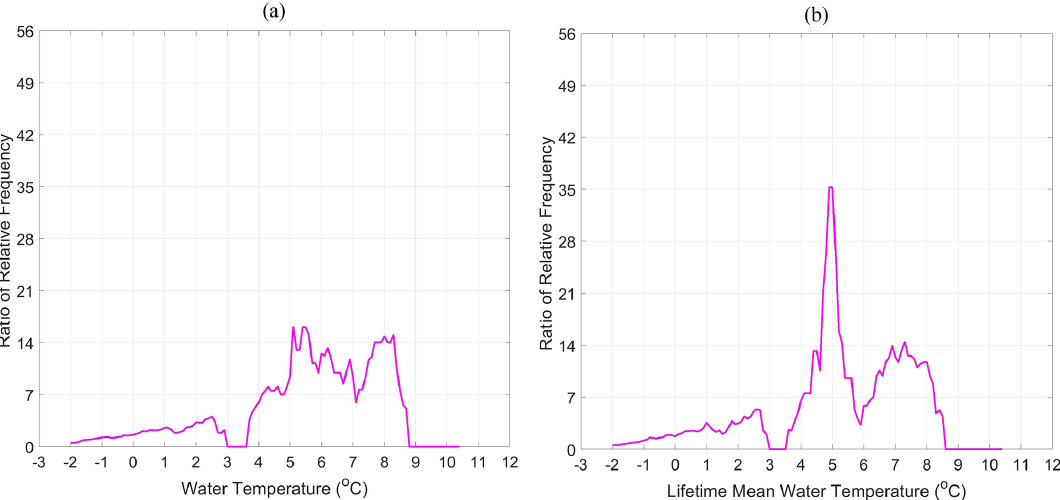
Figure A1. The ratio of the relative frequency for fracture events and all observations over the range of water temperature (a) and lifetime mean water temperature (b) that surrounded the Petermann ice islands. Values close to 1 imply that fracture events are as likely to occur as the frequency of observations. Values larger than 1 indicate that fracture events are more likely to occur than the frequency of observations. Values less than 1 imply that fracture events are less likely to occur relative to the frequency of observations.